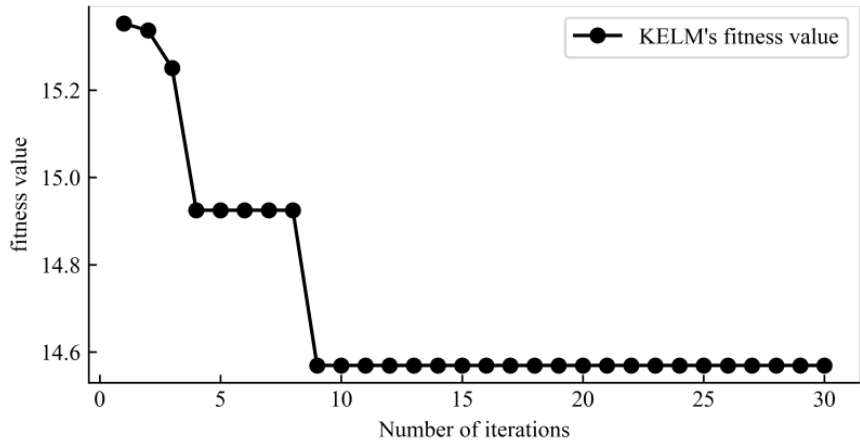
Figure 9. GA optimizes KELM’s fitness curve.